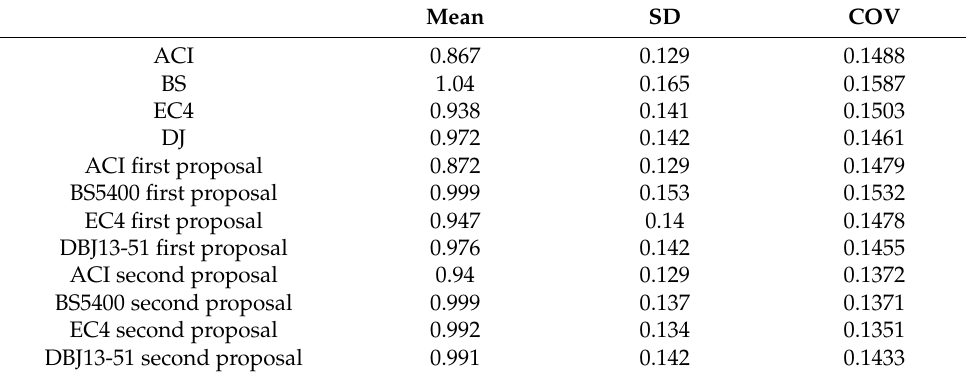
Table 1. Comparisons of square and rectangular CFT stub column capacity produced using different equations with the experimental results.